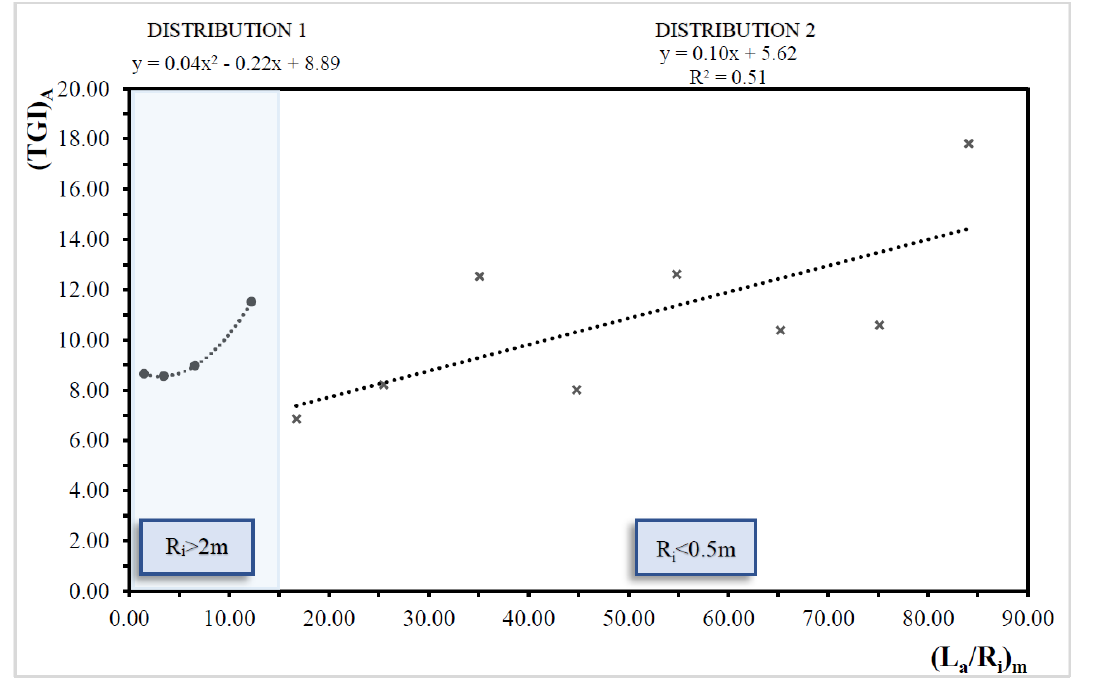
Figure 9. (L a /R i ) m vs. (TGI) A .